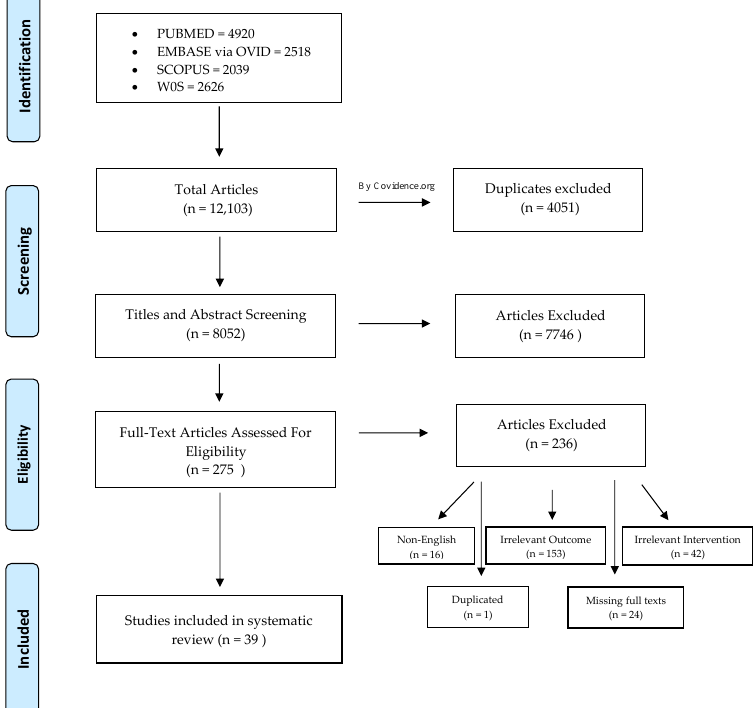
Figure 1. Flow diagram of the study screening and selection.